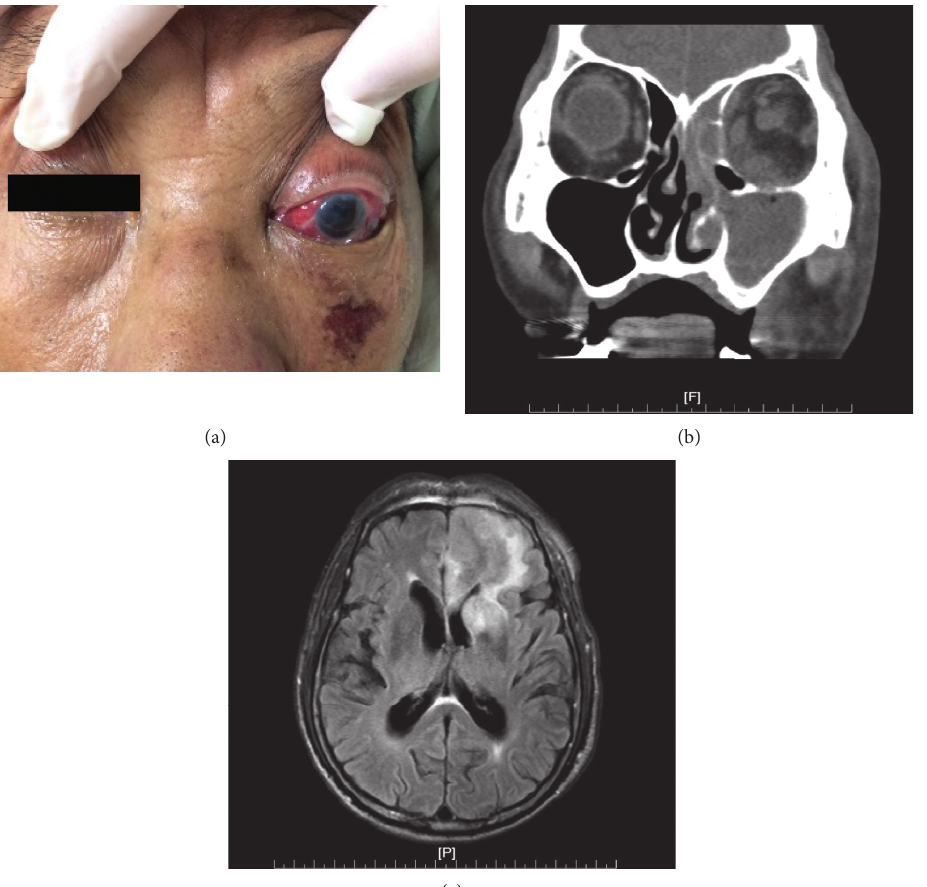
Figure 1: This was a 73-year-old male patient. He died 22 days after disease onset. The culture reported Rhizopus . (a) The patient presented as left facial swelling and tenderness, left eye proptosis, painful extraocular movement, eyelid swelling and erythema, conjunctival injection and chemosis, and cornea edema. (b) Computed tomography revealed orbital intraconal infiltration, extraocular muscles swelling, and sinusitis over maxillary and ethmoid sinuses. (c) Magnetic resonance imaging was performed 2 days after the CT, which revealed ipsilateral brain edema with midline